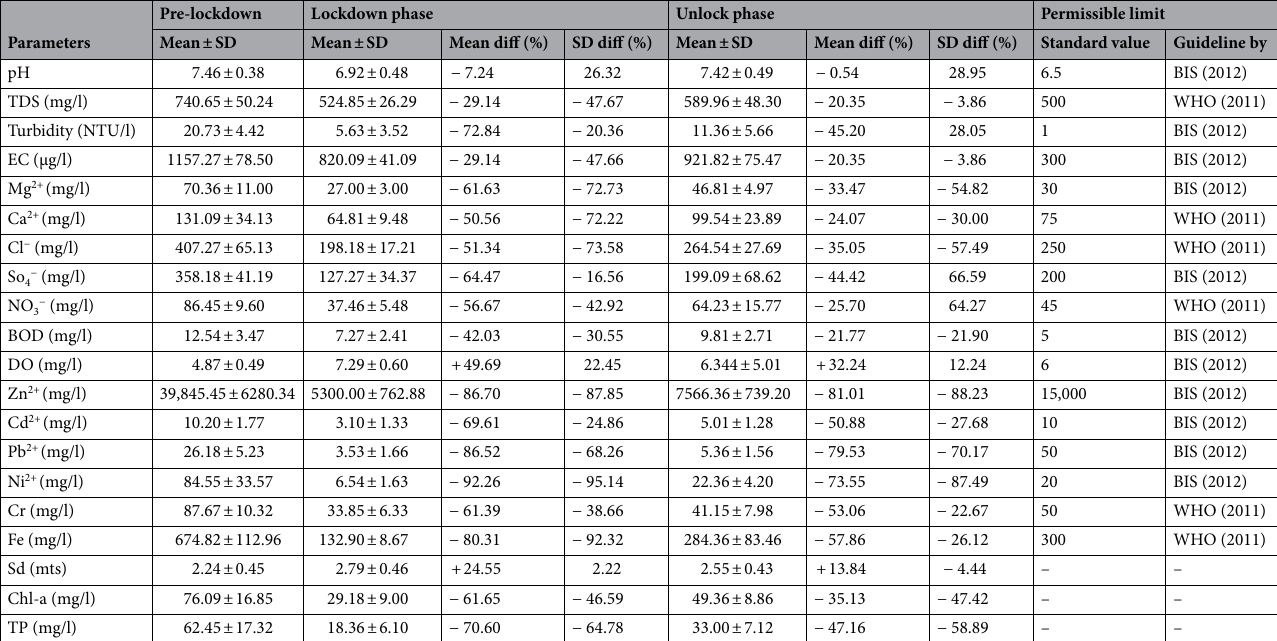
Table 1. Descriptive statistics of twenty variables of physio chemical, heavy metals and biological parameters in three period. SD standard deviation, BIS Bureau of Indian Standards, WHO World Health